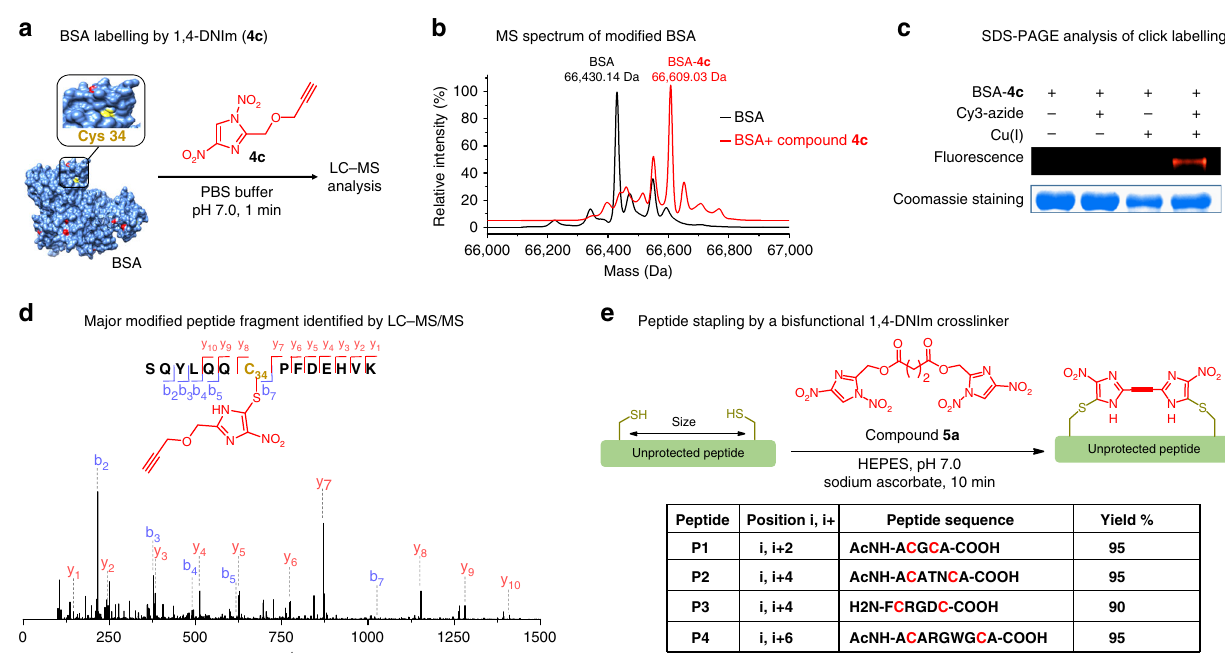
Fig. 4 Thiol-speci fi c labeling of BSA protein and peptide stapling by 1,4-DNIm derivatives. a Bioconjugation of derivative 4c with BSA. The free thiol of Cys34 residue is highlighted in yellow. b ESI-MS spectra of BSA protein before and after treatment with compound 4c . Molecular mass (average): BSA calcd. 66,429.98Da, observed 66,430.14 Da; BSA- 4c calcd. 66,609.12 Da, observed 66,609.03 Da. c Gel image of the reaction between BSA- 4c conjugate and sulfo-Cy3-azide by a CuAAC reaction. d LC-MS/MS analysis of a modi fi ed peptide fragment from trypsin digestion of BSA- 4c conjugate. e Macrocyclization of cysteine-containing unprotected peptides by a bisfunctional 1,4-DNIm ( 5a ). Conditions: peptides (1.0 mM) and compound 5a (1.0 mM) and sodium ascorbate (2.0 mM) were incubated in 100 mM HEPES buffer at pH 7.0 for 10 min before acidi fi ed with formic acid and subjected